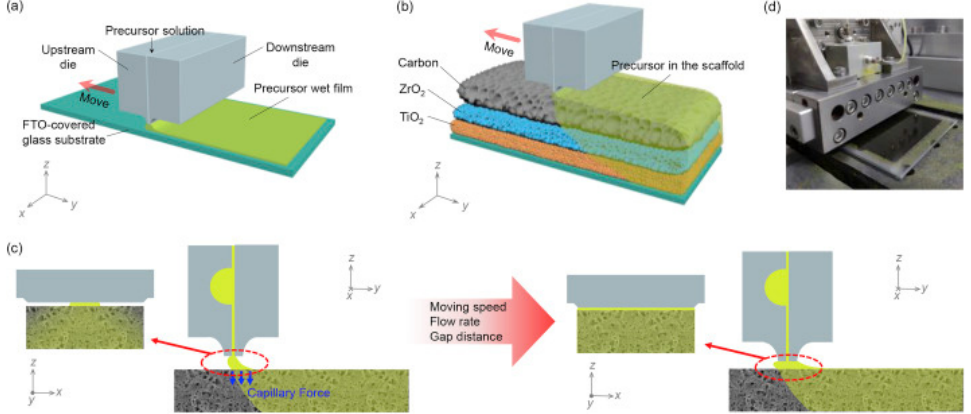
Figure 23 . ( a , b ) The scheme of slot-die coating for depositing a wet film using perovskite precursors on an FTO-covered glass substrate and on a mesoporous scaffold of TiO 2 /ZrO 2 /C. ( c ) The scheme of applying the slot-die coating technique with non-optimized and optimized parameters (moving speed, flow rate, gap distance) on a mesoporous layer. ( d ) The digital image for casting perovskite precursor on a mesoporous scaffold of TiO 2 /ZrO 2 /C [101]. (Reproduced from Ref. [101], 10.1016/j.nanoen.2020.104842, with